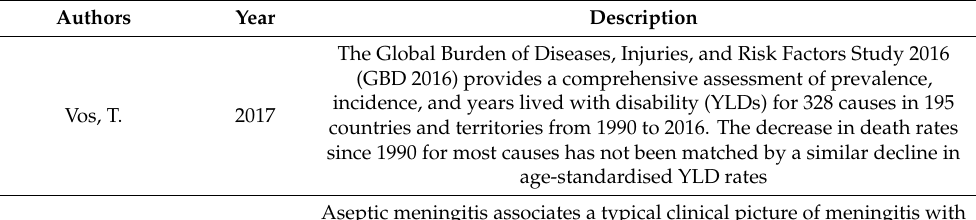
Table 1. A total of 81 studies fulfilled the inclusion criteria. Details of all studies included in this systematic